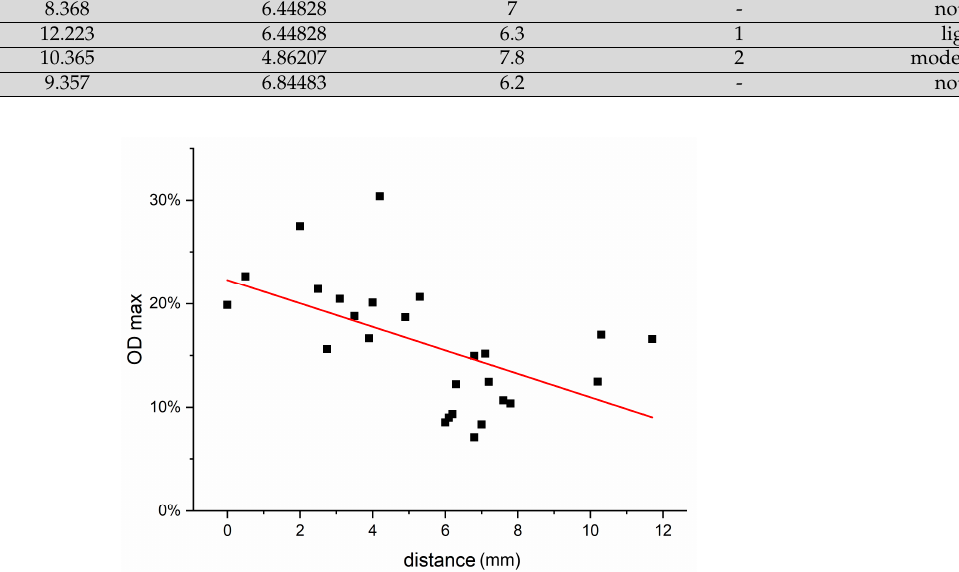
Figure 9. Graphic presentation of the time points of maximum mean optical density of all brain areas with their distance (mm) from the ipsilateral CPu. Plotted are the values for the temporal occurrence of the virtual maximum OD of the examined brain areas as well as the distance of their gravitational centers to that of the BoNT-A-injected CPu. There is a slight linear correlation (rank correlation coefficient according to Spearman = 0.45; p = 0.021) of the time point at which the maximum OD occurs (in the interpolated curves) and the distance from the injection site. The red line is the regression line calculated from the compared values.